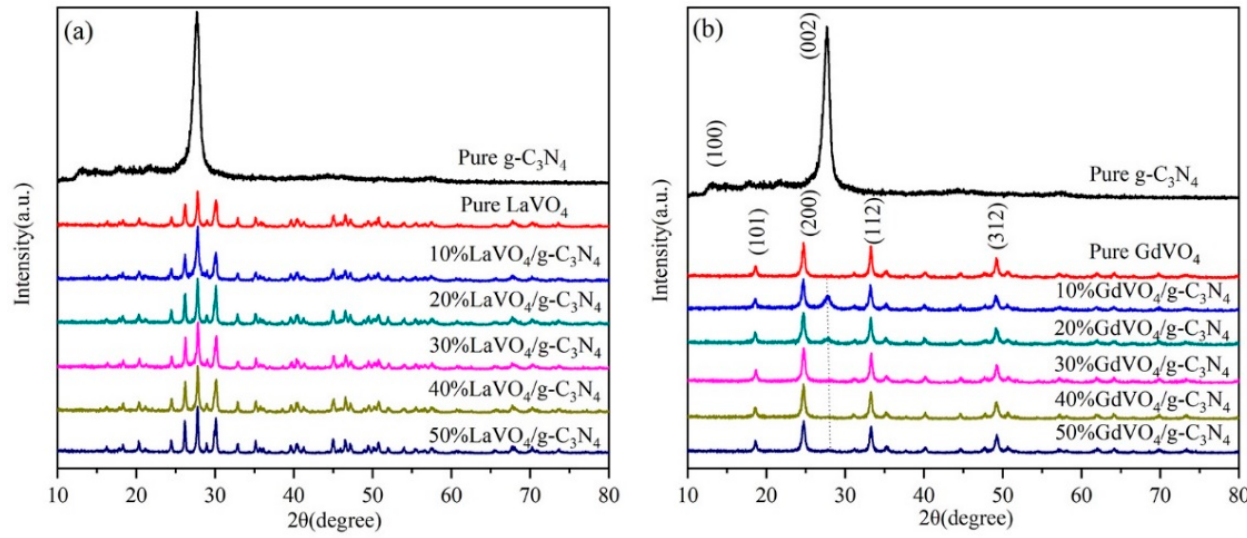
Figure 1. XRD patterns of ( a ) g-C 3 N 4 , LaVO 4 , and 10–50%LaVO 4 /g-C 3 N 4 , ( b ) g-C 3 N 4 , GdVO 4 , and 10–50%GdVO 4 /g-C 3 N